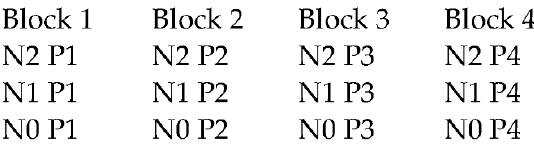
Figure 1. Experimental design.